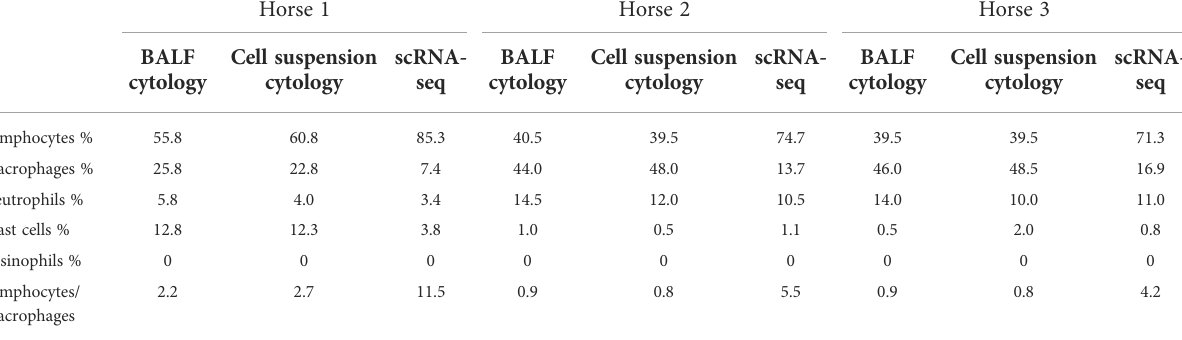
TABLE 3 Differential cell counts (DCC) obtained with conventional cytology and single-cell RNA sequencing